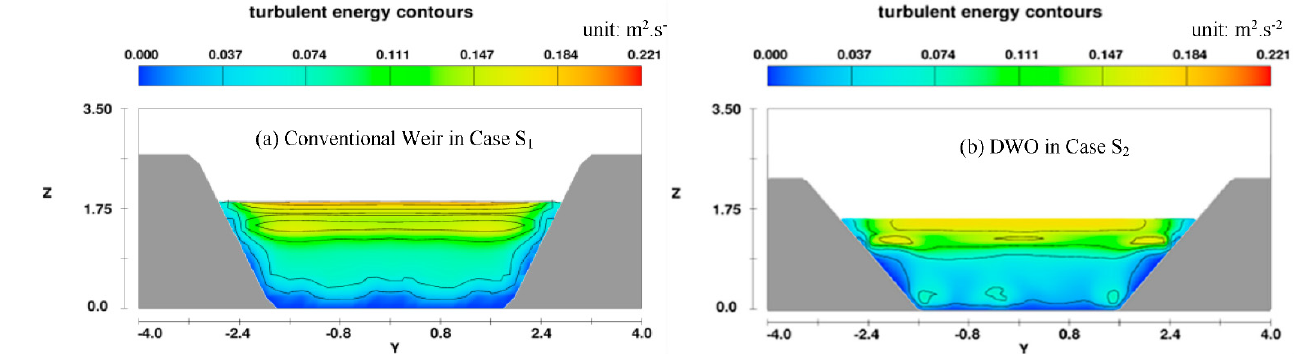
Figure 16. Turbulent energy contours of the cross-section ( x/L =0.41, middle stream) for the conven- tional weir of Case S 1 and the DWO of Case S 2 in panel ( a , b ). It can be seen that as the water depth is lower than upstream, the flow turbulence in the upper layer starts to affect the lower layer. The upper turbulent strength in Case S 1 is larger than that in Case S 2 , and the bottom turbulent energy in the DWO (Case S 2 ) is larger than that in the conventional weir (Case S 1 ). The turbulent conditions in both the upper and bottom layers in S 2 are more suitable for fish migration than those in S 1 . The meanings of all the variables and symbols in the figure are the same as above.